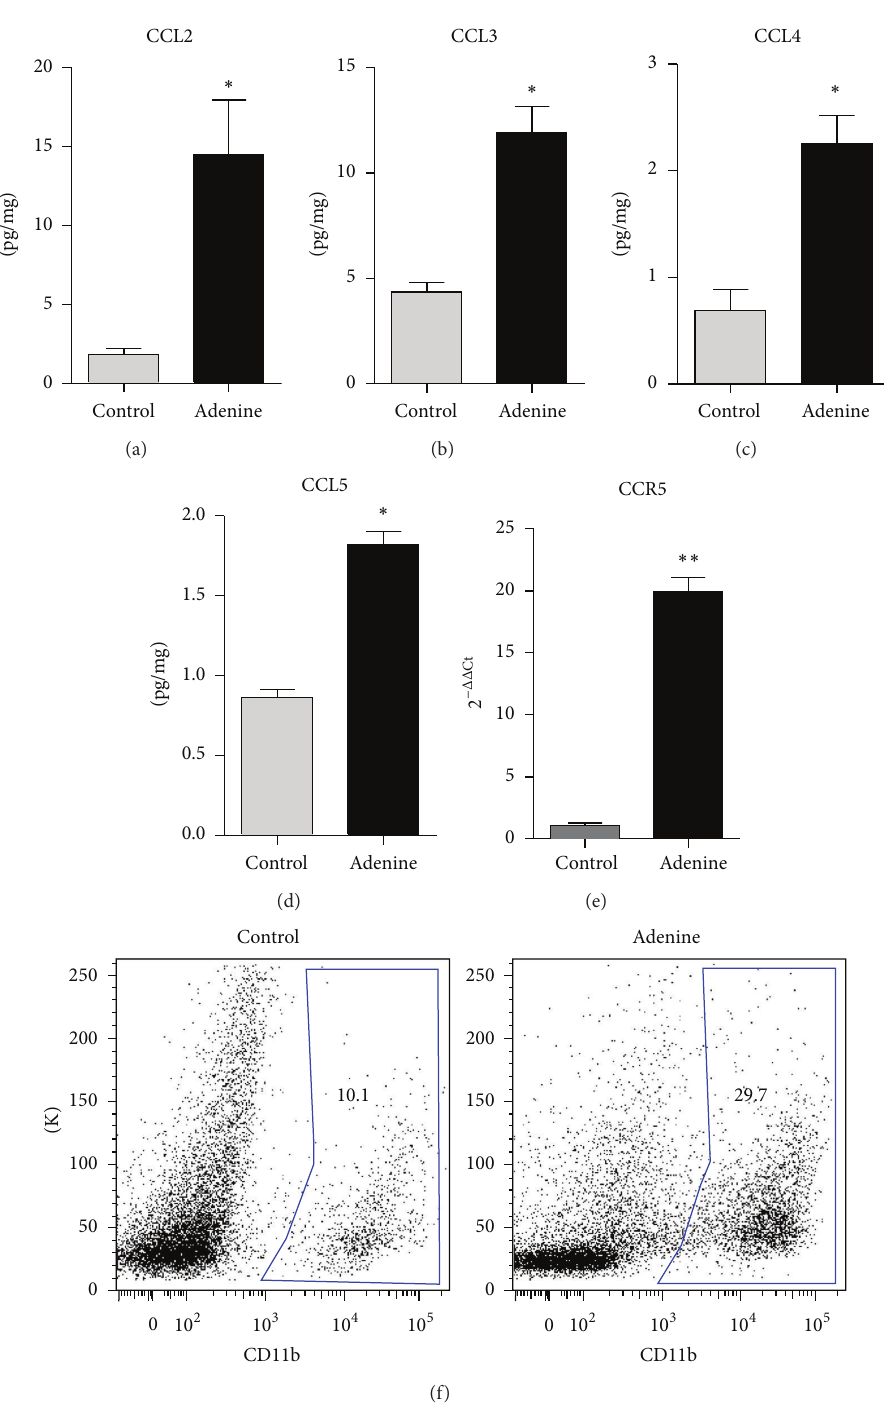
Figure 1: Adenine-enriched food increases the expression of chemokines and macrophages in renal tissue. Protein expression of CCL2 (a), CCL3 (b), CCL4 (c), and CCL5 (d) was measured in kidney lysates of animals that received standard food or adenine-enriched food. Panel (e) shows the gene expression of CCR5 in the same animals. In panel (f) the dot plot of macrophage infiltration is shown, observed by the CD11b marker. ∗ 𝑃 < 0.05 versus control and ∗∗ 𝑃 < 0.01 versus